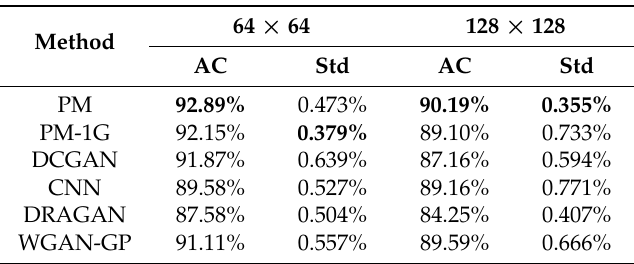
Table 3. The mean accuracy and STD of our network, supervised CNN, DCGAN, DRAGAN, and WGAN-GP trained by 600 labeled